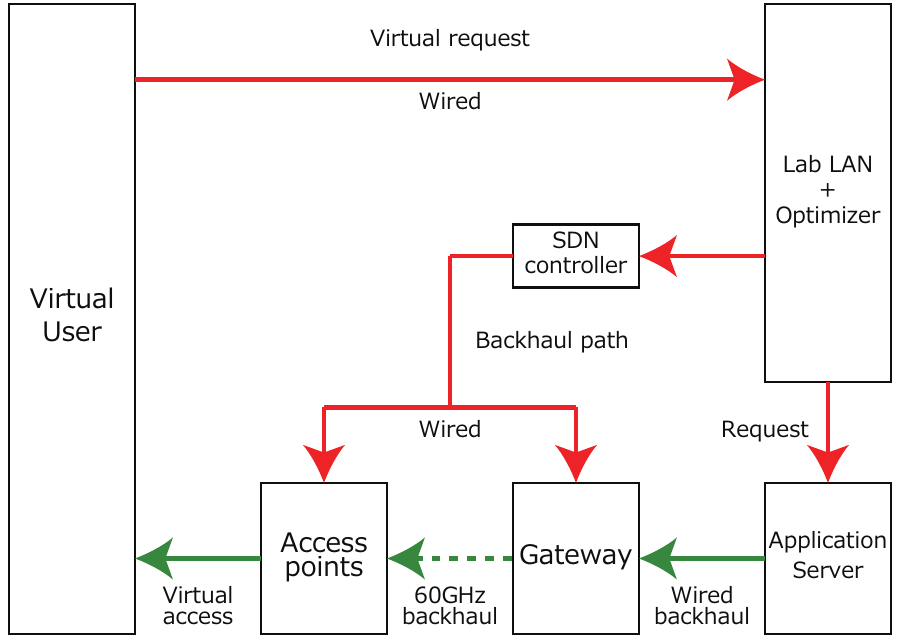
Figure 13. System configuration of each AP.